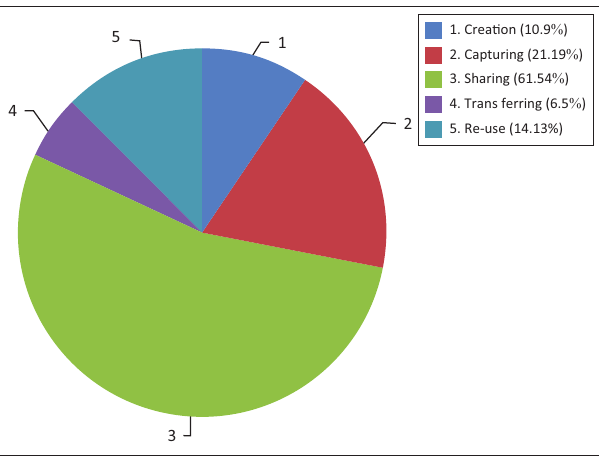
FIGURE 1: Importance of the knowledge management processes.